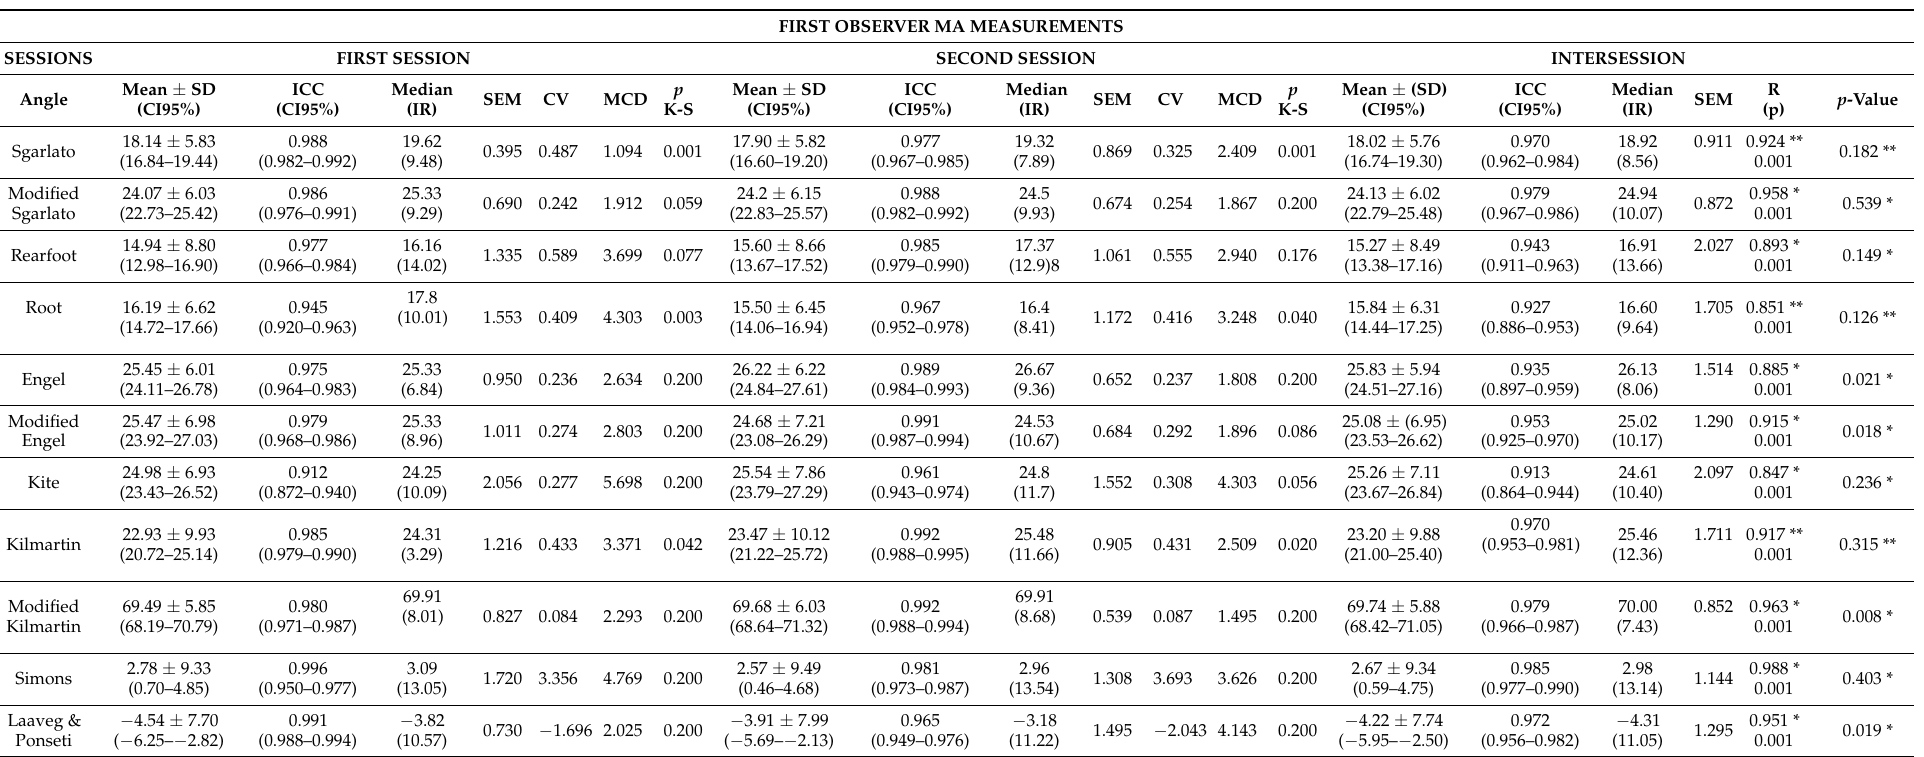
Table 2. Analysis of metatarsus adductus angle measurements between the first and second sessions by the first observer and normalized